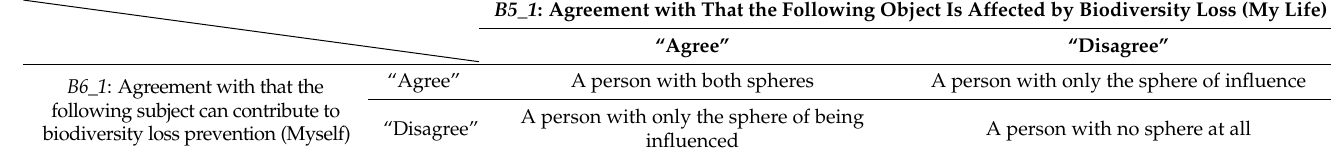
Table 3. Categorization of urban residents’ subjective spheres of